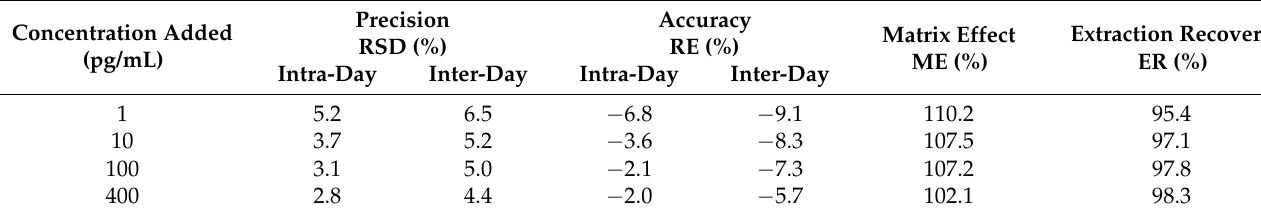
Table 1. Intra-day and inter-day precision and accuracy, extraction recovery and matrix effect for OXA-spiked rat vitreous body (n = 6).